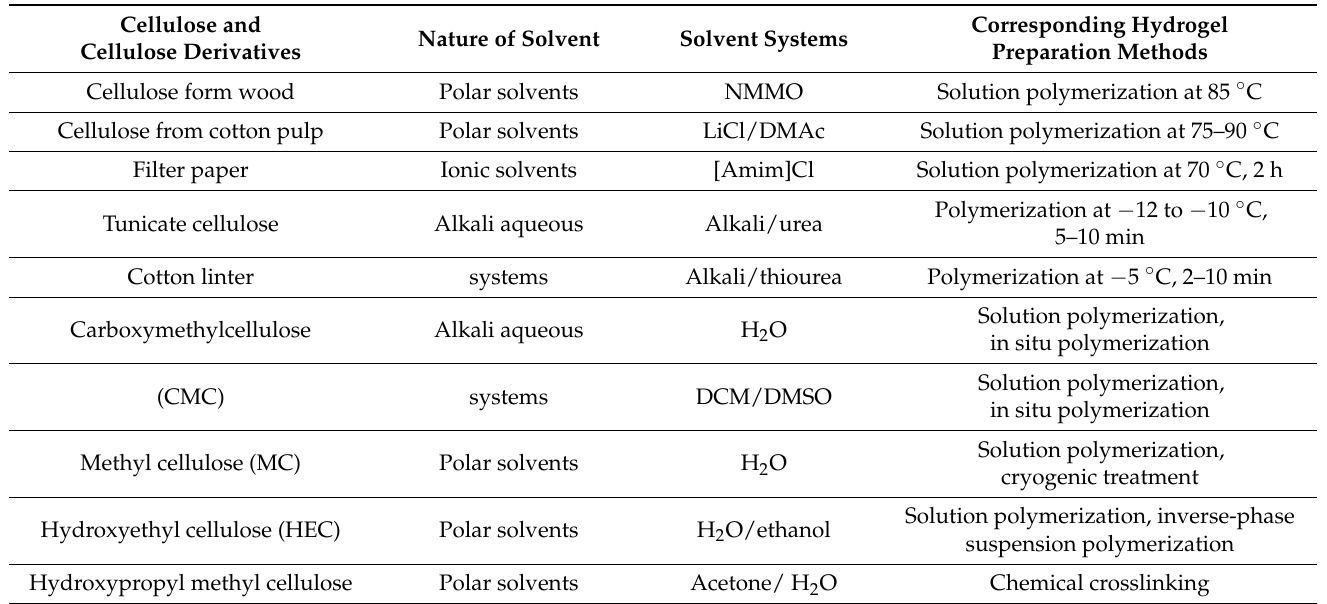
Table 1. Summary of some cellulose derivatives and their corresponding hydrogel processing methods (copied from Reference [58]).